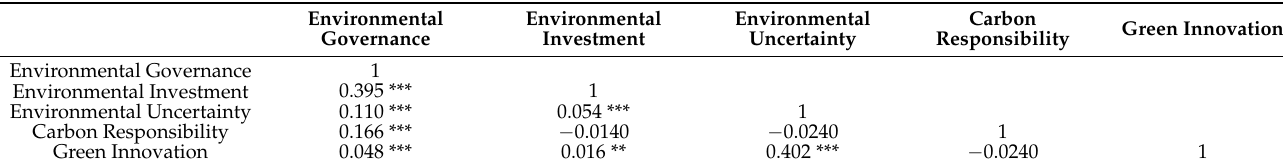
Table 2. Correlation Analysis.